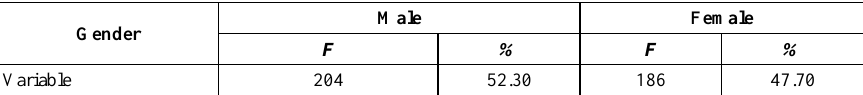
Table 1. Distribution of university students by gender